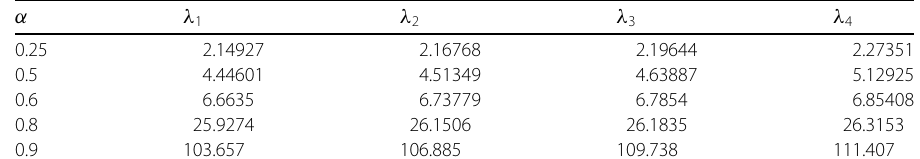
Table 2 Numerical approximations to the first four eigenvalues of problem (24)–(25) according to (cid:12) 750 E δ , θ ( z ) = k =0